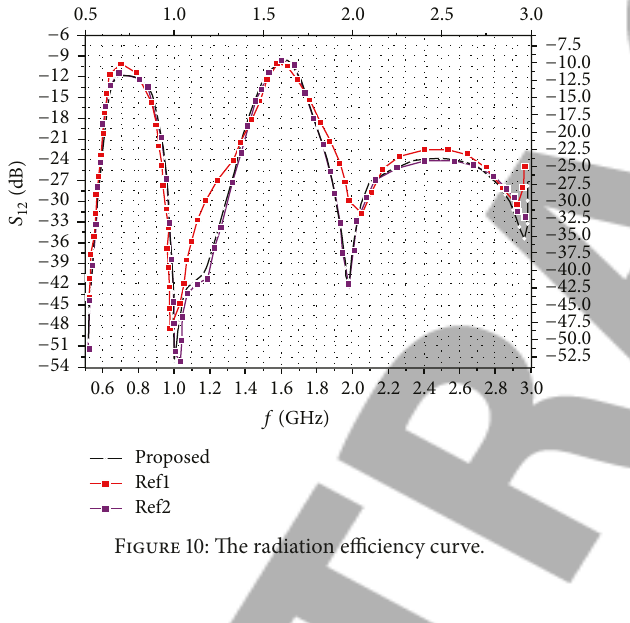
Figure 11: ECC of correlation coefficient